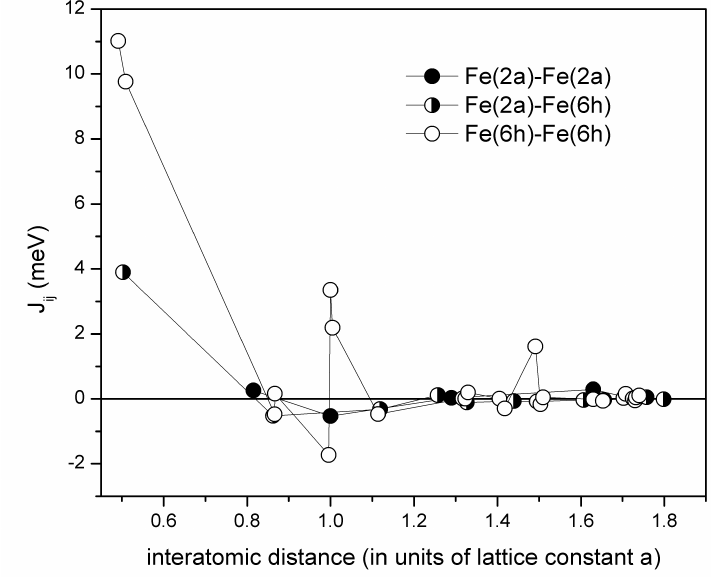
Figure 3. The inter-site exchange interactions in hexagonal Fe 2 Hf compound calculated in the disordered local moment (DLM) state. Open symbols are for the (2a)–(2a) Fe intra-sublattice interactions, closed symbols are for (6h)–(6h) intra-sublattice interactions, and semi-closed symbols denote the inter-sublattice (2a)–(6h) interactions. The calculations are presented for up to 50 nearest-neighbor